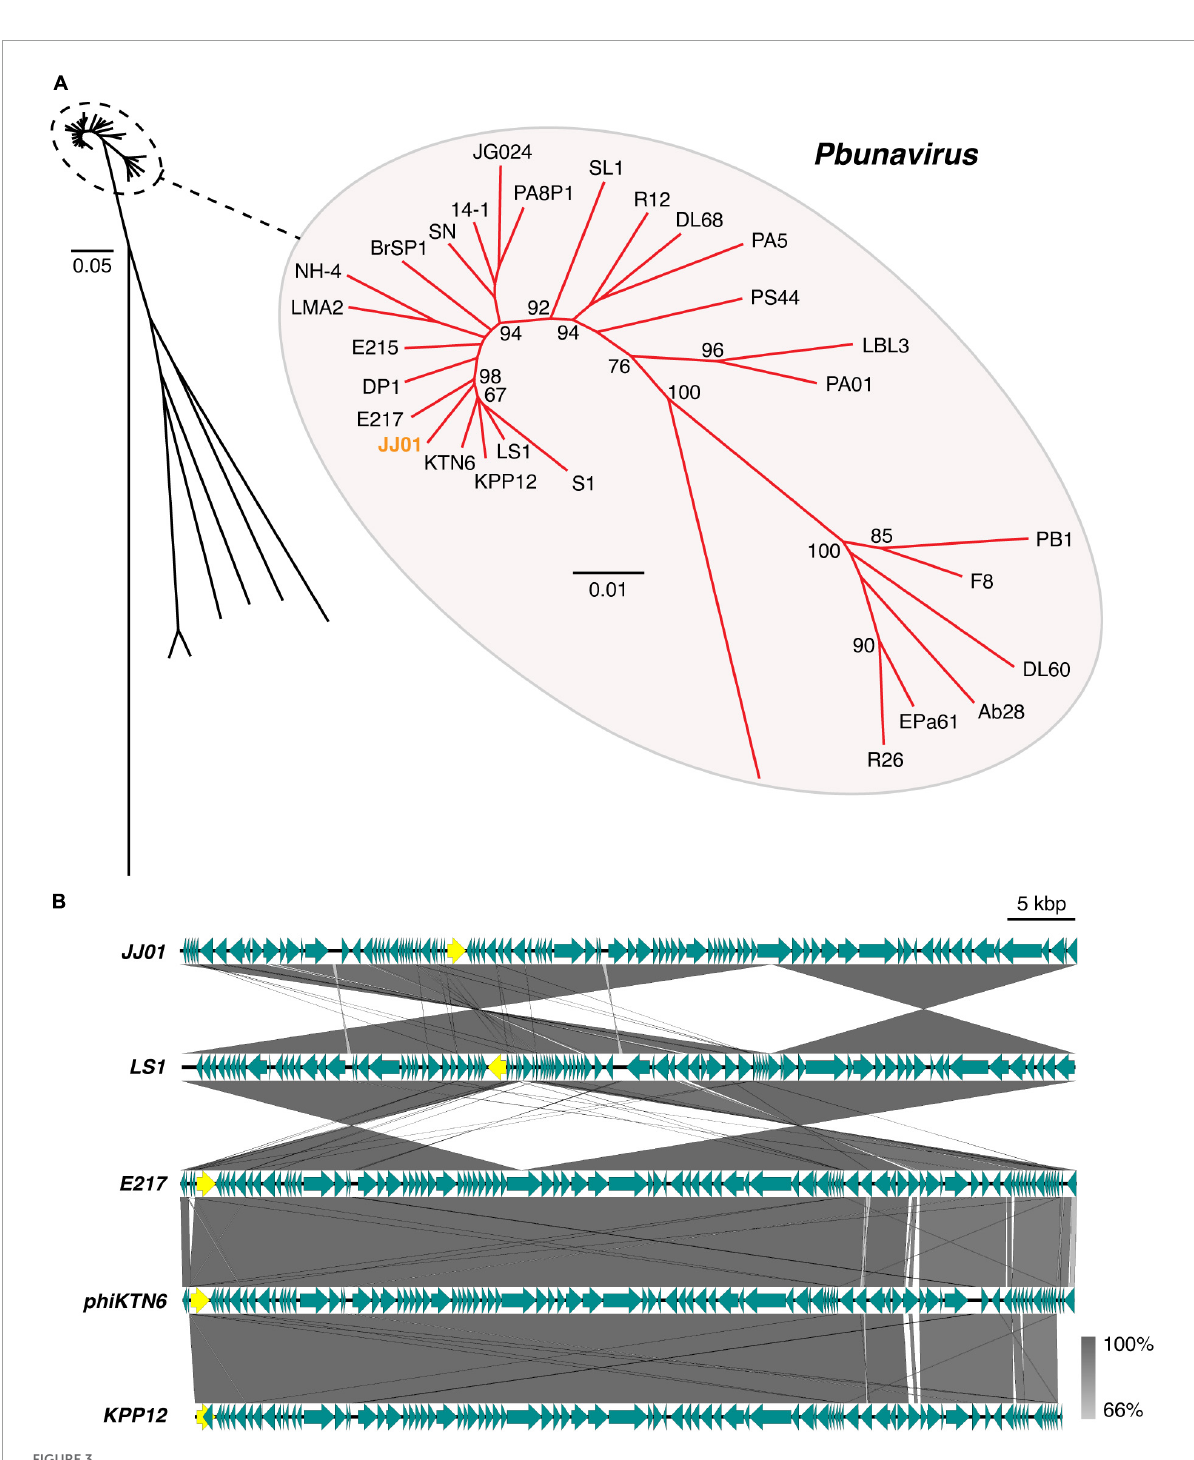
FIGURE3 (A) Genome phylogenetic tree between species in Pbunavirus according to ICTV approval constructed using MAFFT version 7 with 1,000x Bootstrap. Numbers at branches represent Bootstrap values (%). Scale bars represent the branch length of taxa. (B) Comparative genomic analysis shows the gene organization of phage JJ01 compared to phages LS1, E217, phiKTN6, and KPP12 whose genomes are closely related to phage JJ01. Yellow labeled arrows represent the location and direction of the large subunit terminase